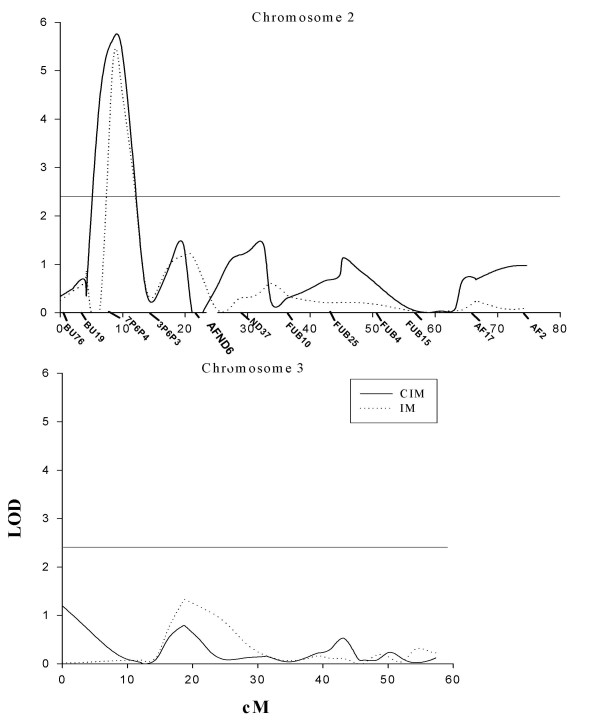
Plot of LOD scores associated with pyrethroid resistance on chromosomes 2 and 3 in family11. Solid lines represent LOD estimated by interval mapping and dashed lines represent LOD estimated by composite-interval mapping. The straight line along the top of each graph represents the threshold value for LOD. Names of markers are listed only on chromosome 2 to orient the unique QTL position.